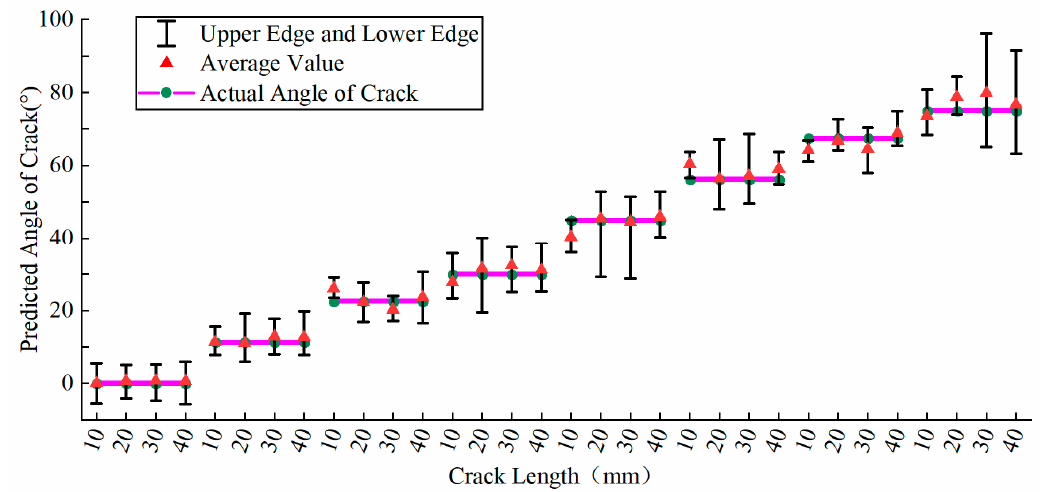
Figure 14. Angle prediction of cracks at different lengths (MIMO-BPNN). Table 2. Predicted deviation range of the mean.